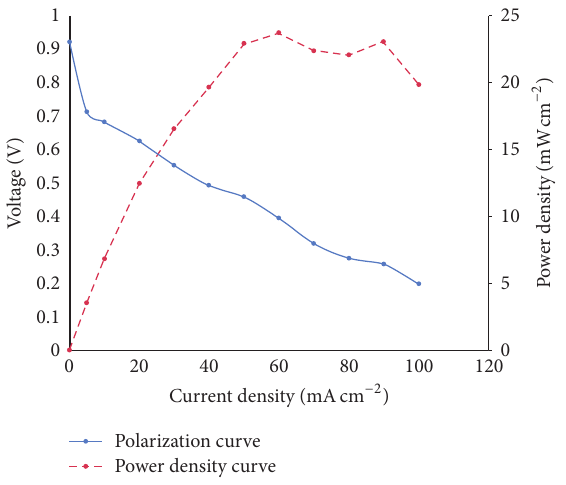
Figure 11: Polarization and power density curves of SPAEB copoly- mer